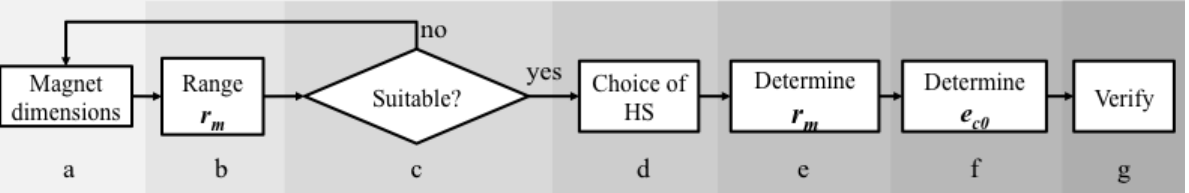
Figure 6. Graphical scheme of the optimization